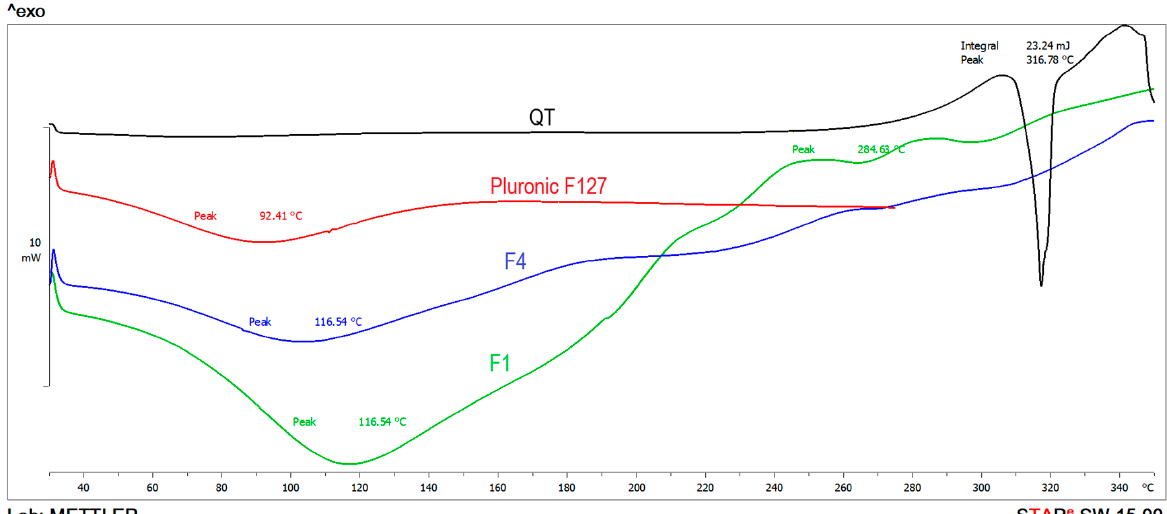
Figure 2. DSC thermograms of of QT, Pluronic F127, F4 and F1.